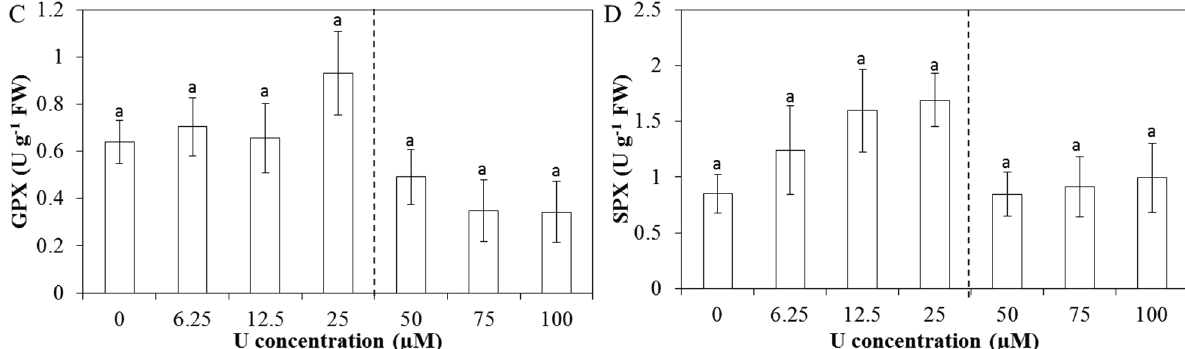
Figure 5. Enzyme capacities (units (U) g − 1 FW) of catalase ( A , CAT); glutathione reductase ( B , GR); guaiacol peroxidase ( C , GPX) and syringaldazine peroxidase ( D , SPX) in Arabidopsis thaliana leaves exposed to different U concentrations for three days at pH 7.5. Values represent the mean ± S.E. of at least four biological replicates. The vertical line indicates the transition from the increasing trend in enzyme capacities to the decreased capacity. Data points with different letters are significantly different ( p <